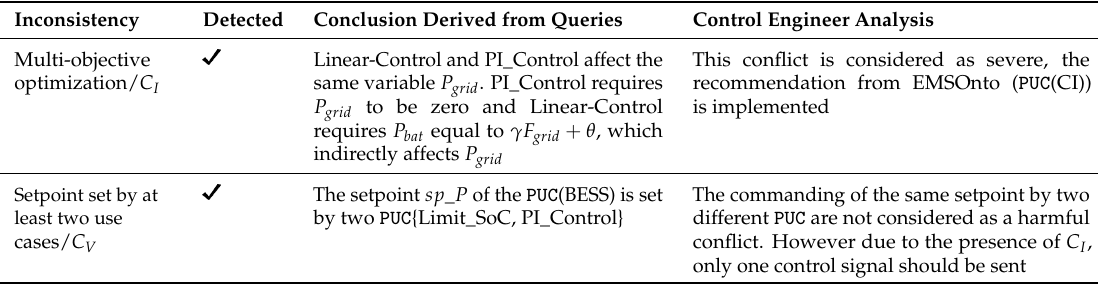
Table 16. Conflicts triggered by reports and control engineer